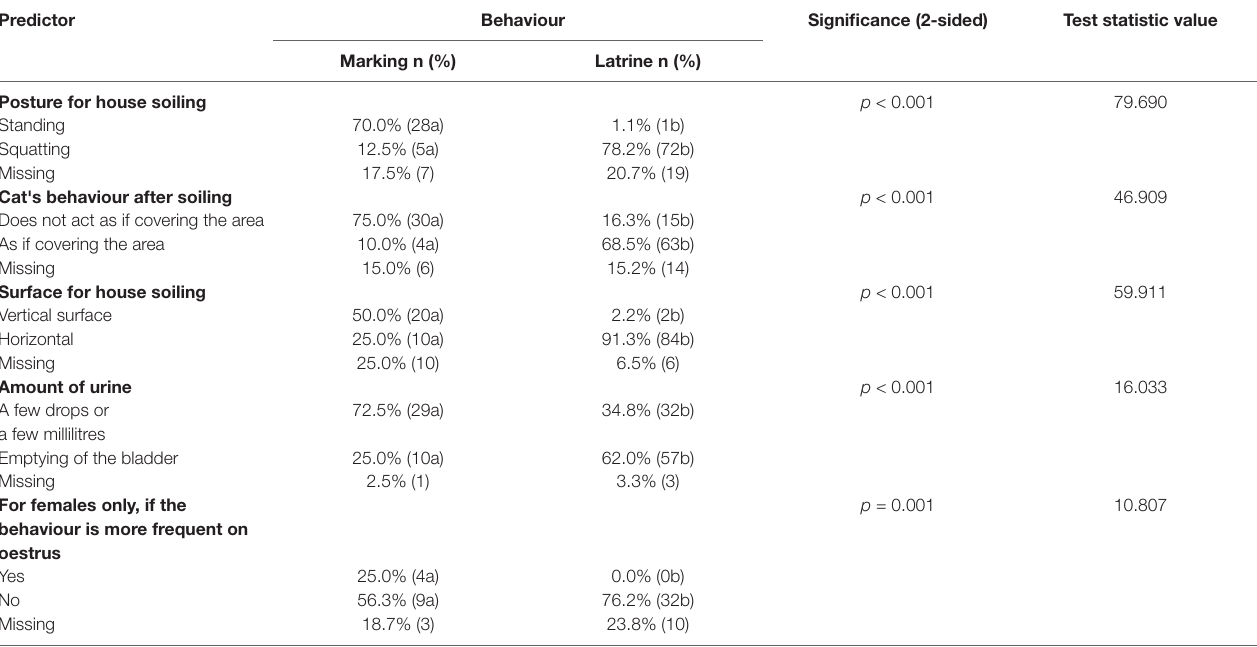
TaBle 7 | Significant predictors of either marking or latrine behaviour (Chi square test).